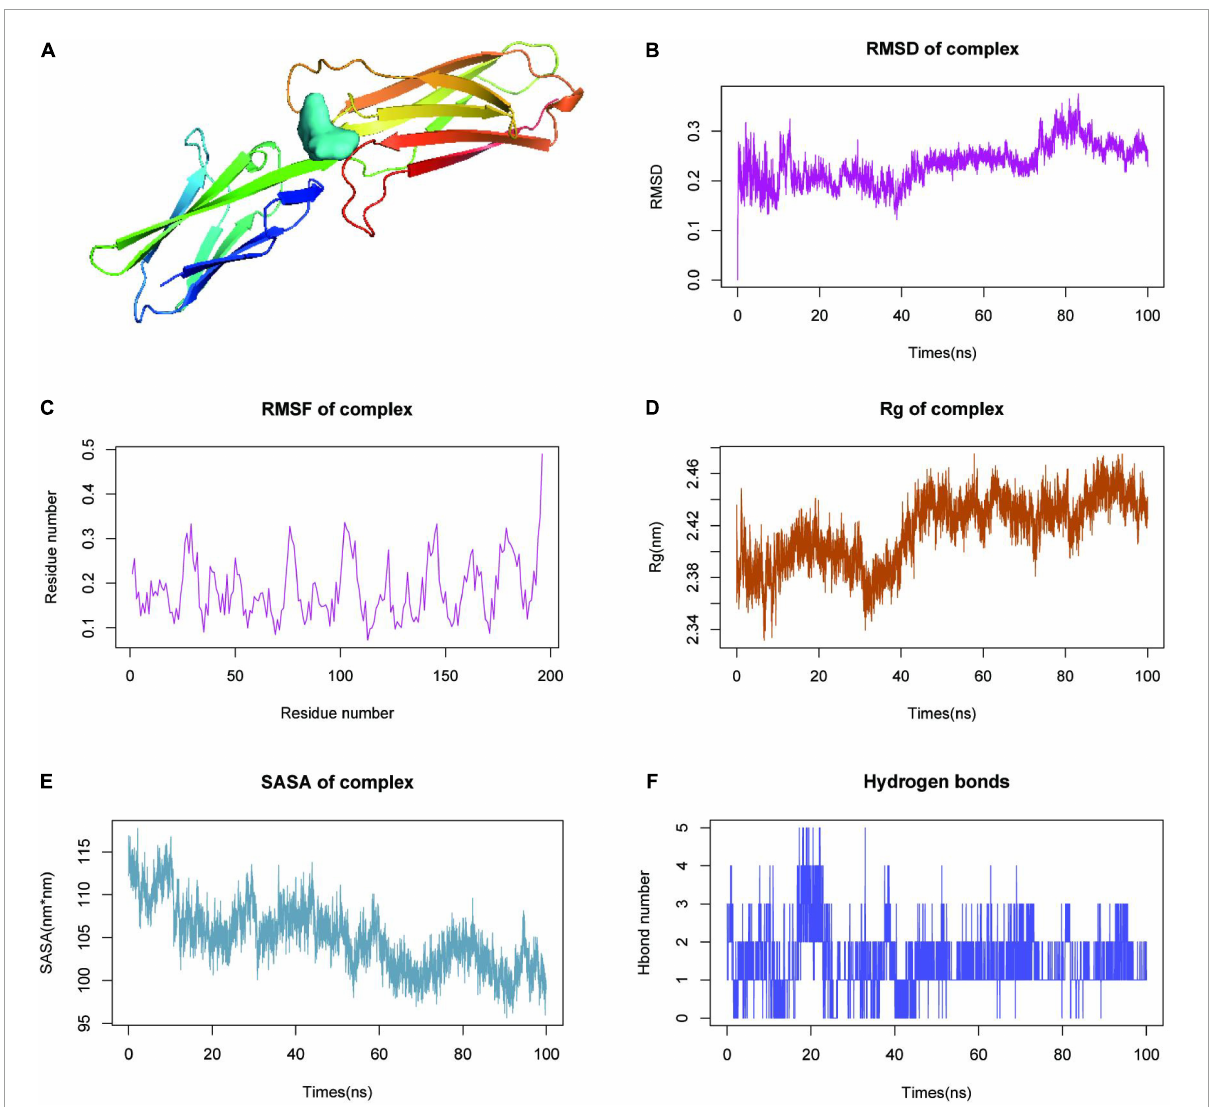
FIGURE6 Molecular dynamics simulation (MDS) analysis of VCAM1-quercetin. (A) Molecular docking results of quercetin-VCAM1 complex. (B) Root-mean-square deviation of quercetin-VCAM1 complex MDS. (C) Root-mean-square fluctuation plot of quercetin-VCAM1 complex MDS. (D) Plot of Rg changes in MDS of quercetin-VCAM1 complex. (E) SASA changes of proteins in quercetin-VCAM1 complex MDS 0–100 ns. (F) Changes in hydrogen bonding in steady state of quercetin-VCAM1